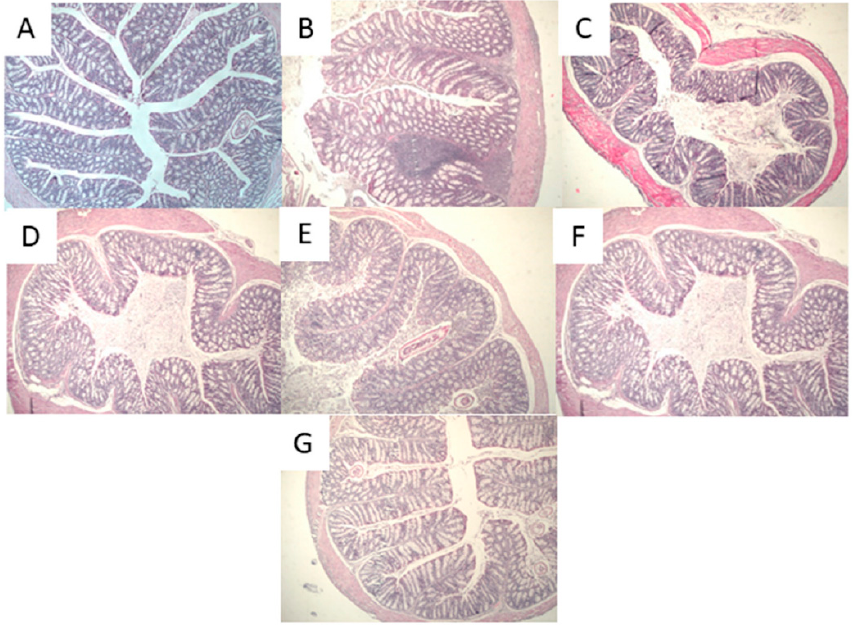
Figure 5. Histological analysis of cross sections of colon tissue samples stained with hematoxylin–eosin (10×): ( A ) water control group; ( B ) DSS group; ( C ) AM + DSS group; ( D ) FM-J20 + DSS group; ( E ) PFM-J20 + DSS group; ( F ) FM-J28 + DSS group; and ( G ) PFM-J28 + DSS group.